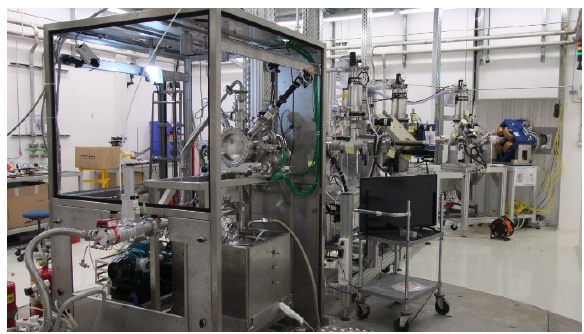
Fig. 8. Picture of the LiLiT-2 system installed at SARAF new target room with the frame of the containment vessel